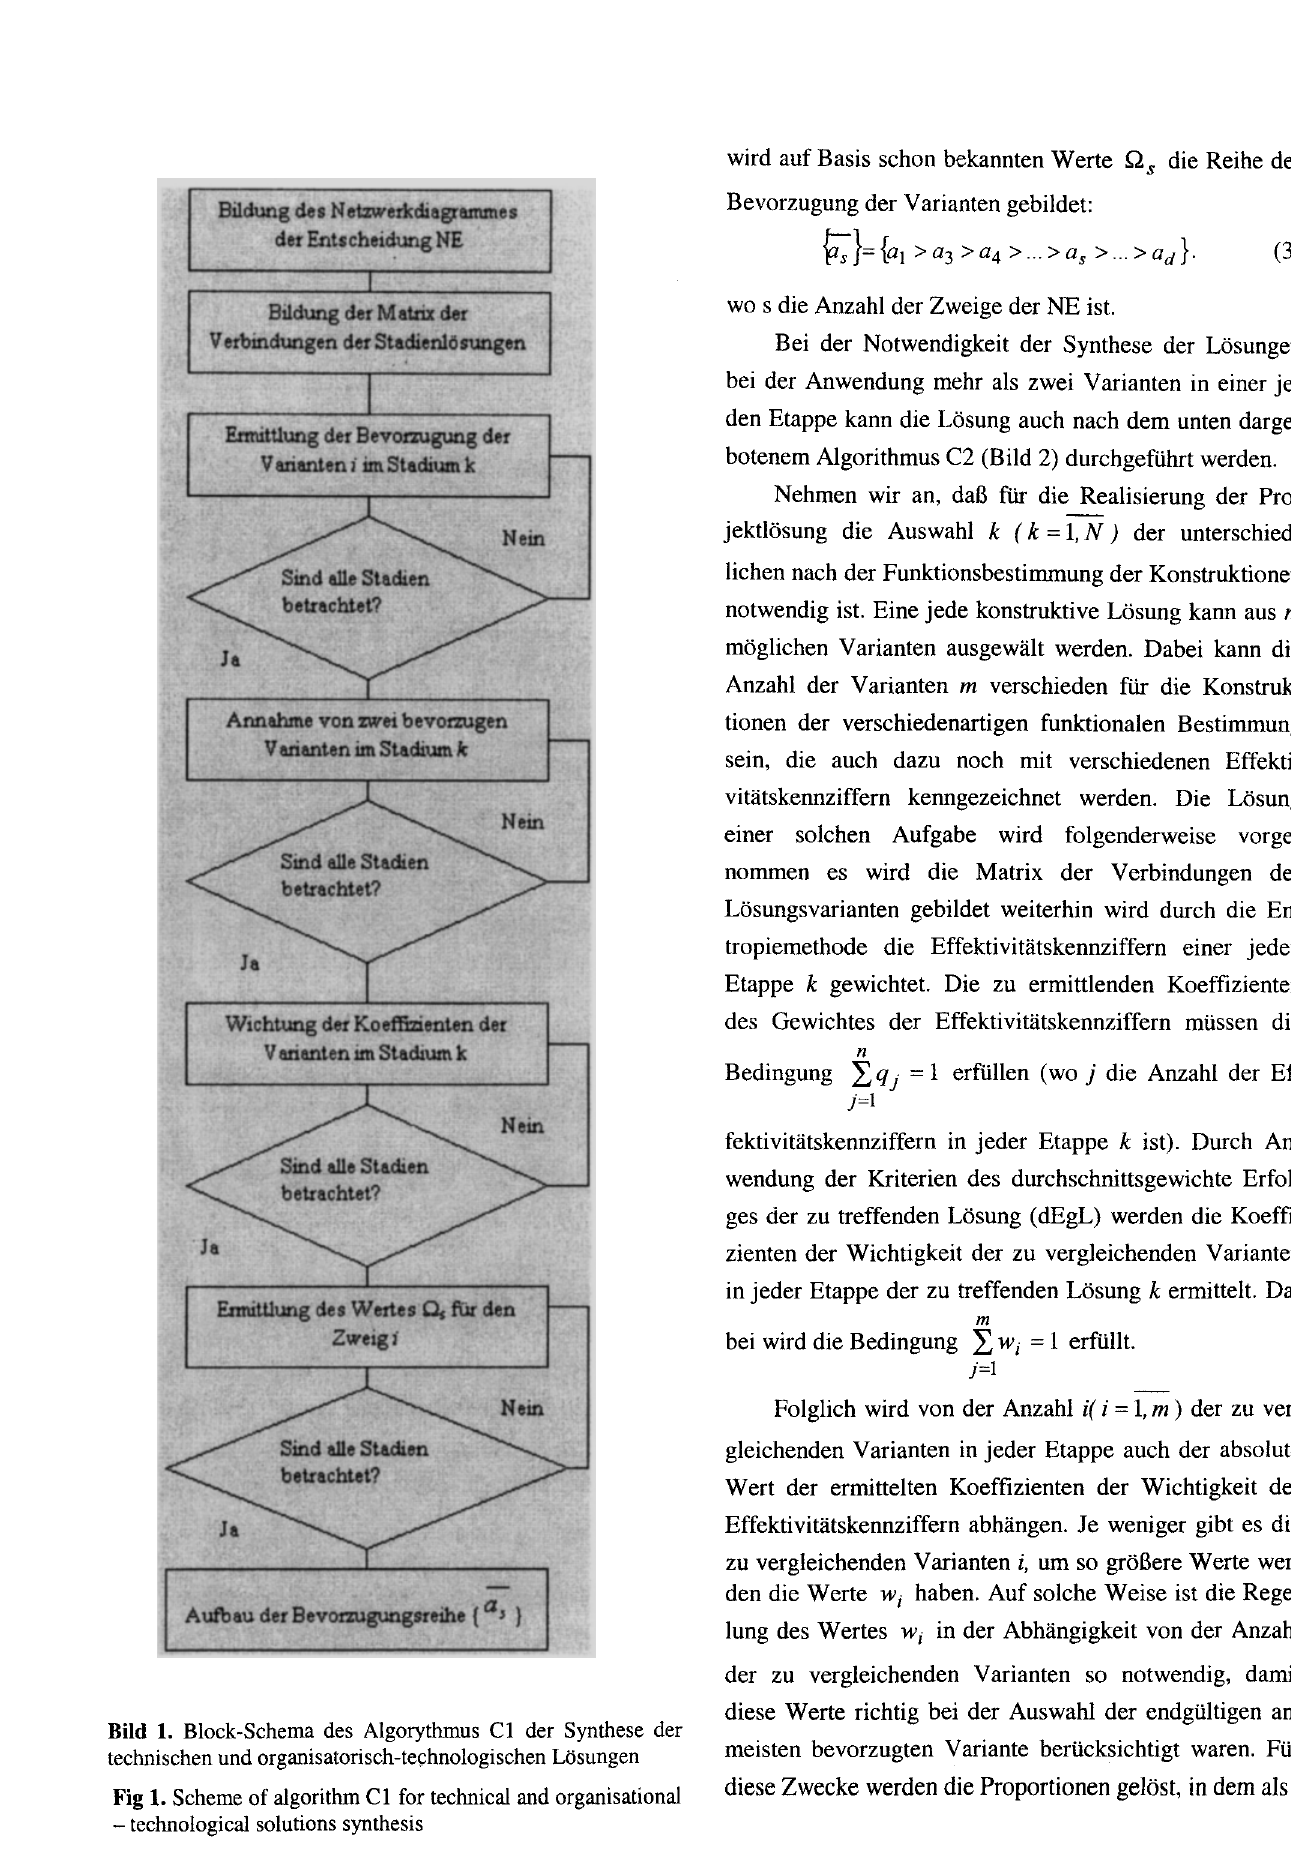
Fig 1. Scheme of algorithm Cl for technical and